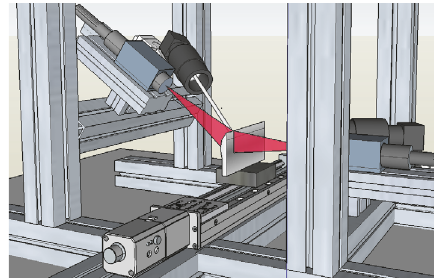
Figure 6: Laser inspection system model.